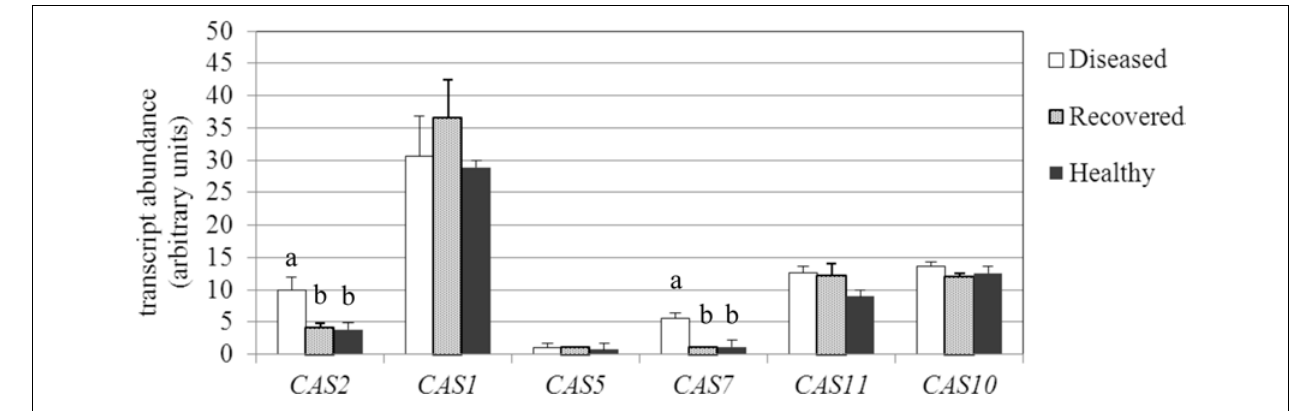
FIGURE 4 | Gene expression analysis of Vitis vinifera callose synthase (CAS) genes. Mean expression (MNE) values from at least three individuals for each plant group (H, D, R) plus standard errors are shown. Expression levels of the genes of interest are normalized to ubiquitin ( UBQ-L40